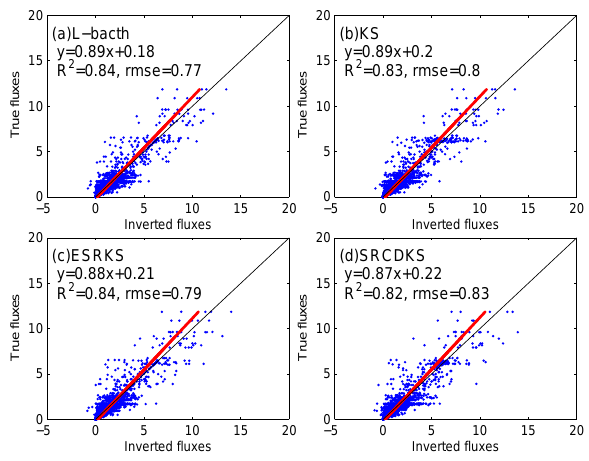
Fig. 2. Inversion results from the interval unconstrained inversion using different methods. A lag length of 7 and a correlation length of 0 are used for all Kalman update smoothers. The ensemble size for ESRKS is 500, and that for SRCDKS is 101. The red lines are the linear regressions of the inversions against the true fluxes.